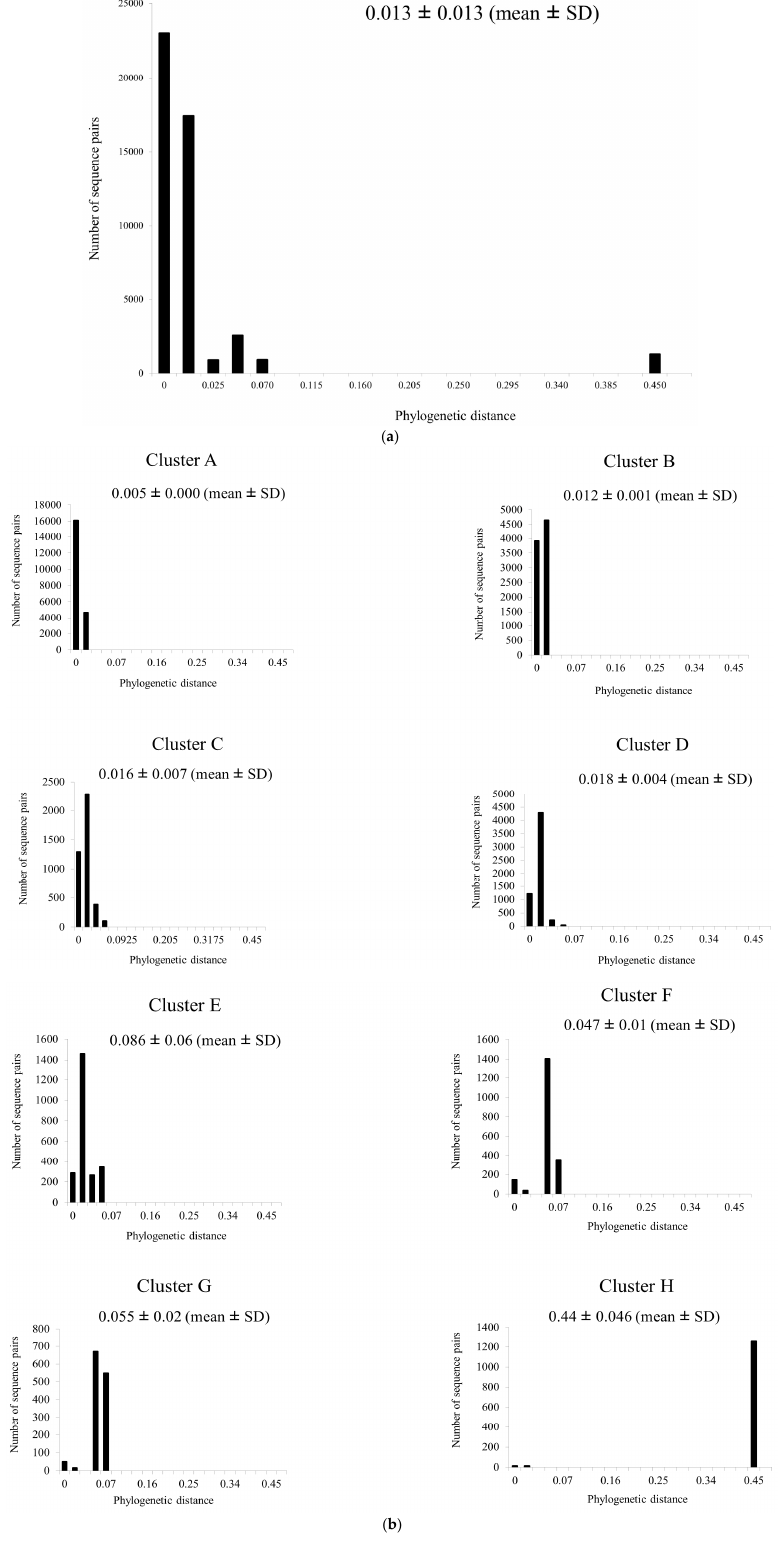
Figure 2. Phylogenetic distances for bla PDC for ( a ) all samples and ( b ) each cluster. The y- and x-axes show the number of sequence pairs and phylogenetic distances, respectively. 3.3. Selective Pressure Analysis We estimated the positive and negative selection sites for the present PDC using the Datamonkey web server. Two amino acid substitutions (amino acids 79 and 239), common to all five methods, were identified as positive selection sites. The number of negative selection sites was 18, 54, 48, and 56 for SLAC, FEL, IFEL, and FUBAR, respectively. Of these, 18 sites were common to all four methods. No positive or negative selection sites were located in motif 1. In contrast, negative selection sites Tyr149, Thr315, and Gly316 were located in motif 2 and motif 3, respectively (Figure 3).